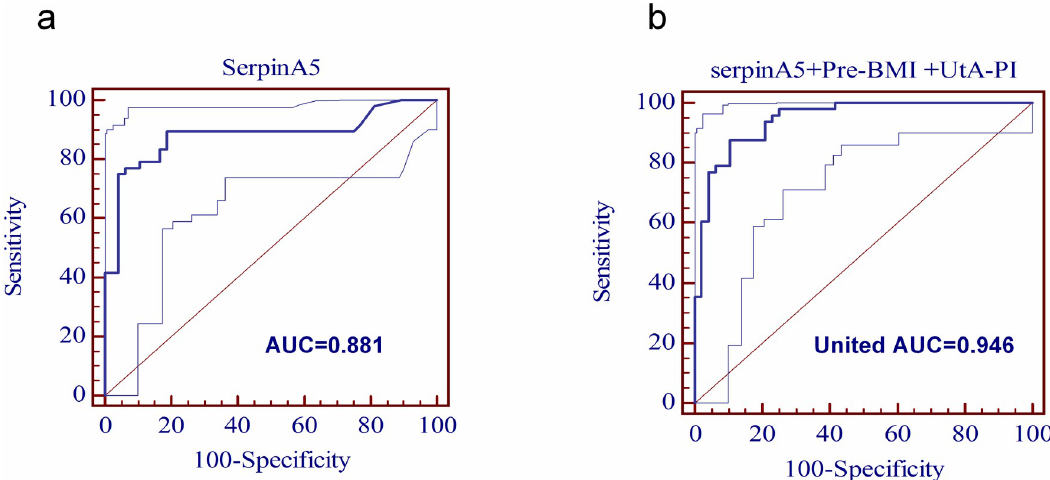
Fig 6. a. Single Prediction analysis. Receiver operating characteristic (ROC) curve analysis. As a single predictor SerpinA5, the AUC = 0.881 (95% CI 0.805–0.956)], with 89.58% sensitivity and 81.25% specificity. b. Combinated Prediction analysis. A combination of plasma SerpinA5, maternal factors and abnormal UtA-PI (above the 95th percentile) enhanced the predictive value for preeclampsia (United AUC was 0.946 (95% CI 0.905–0.988). (Pre-BMI: Pre-pregnancy BMI).